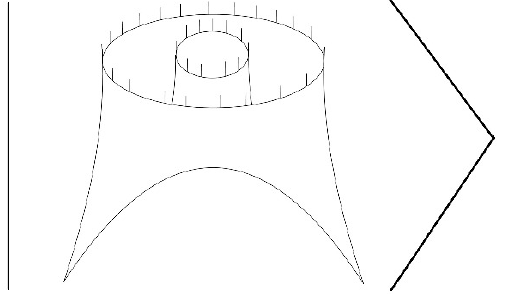
Figure 14 . The Hilbert vector corresponding (cid:12)gure 13, to be included when calculating S-matrix